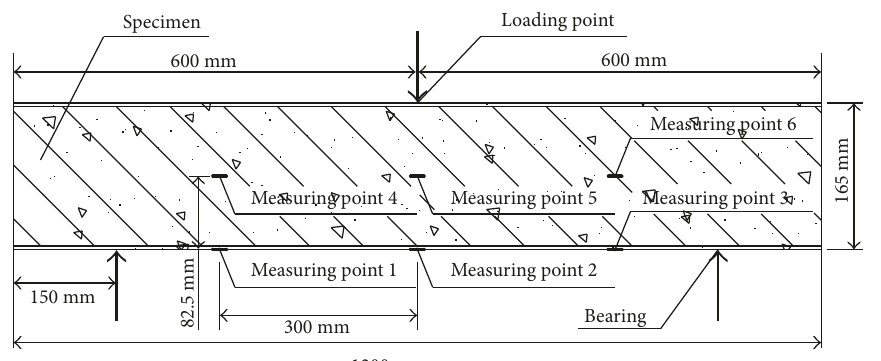
Figure 3: Point position